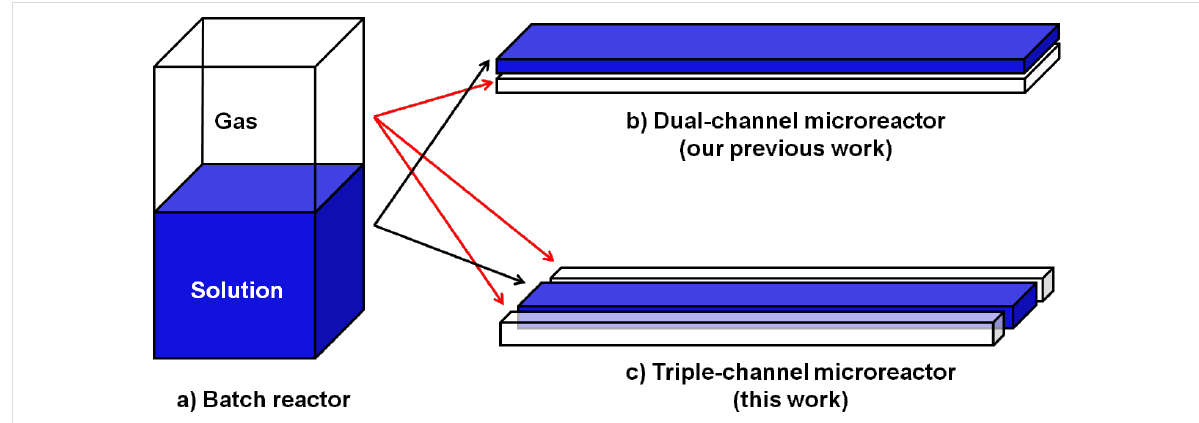
Figure 1: Schematic the for contacting modes of biphasic gas–liquid in (a) batch reactor, (b) dual-channel, and (c) triple-channel microreactors.